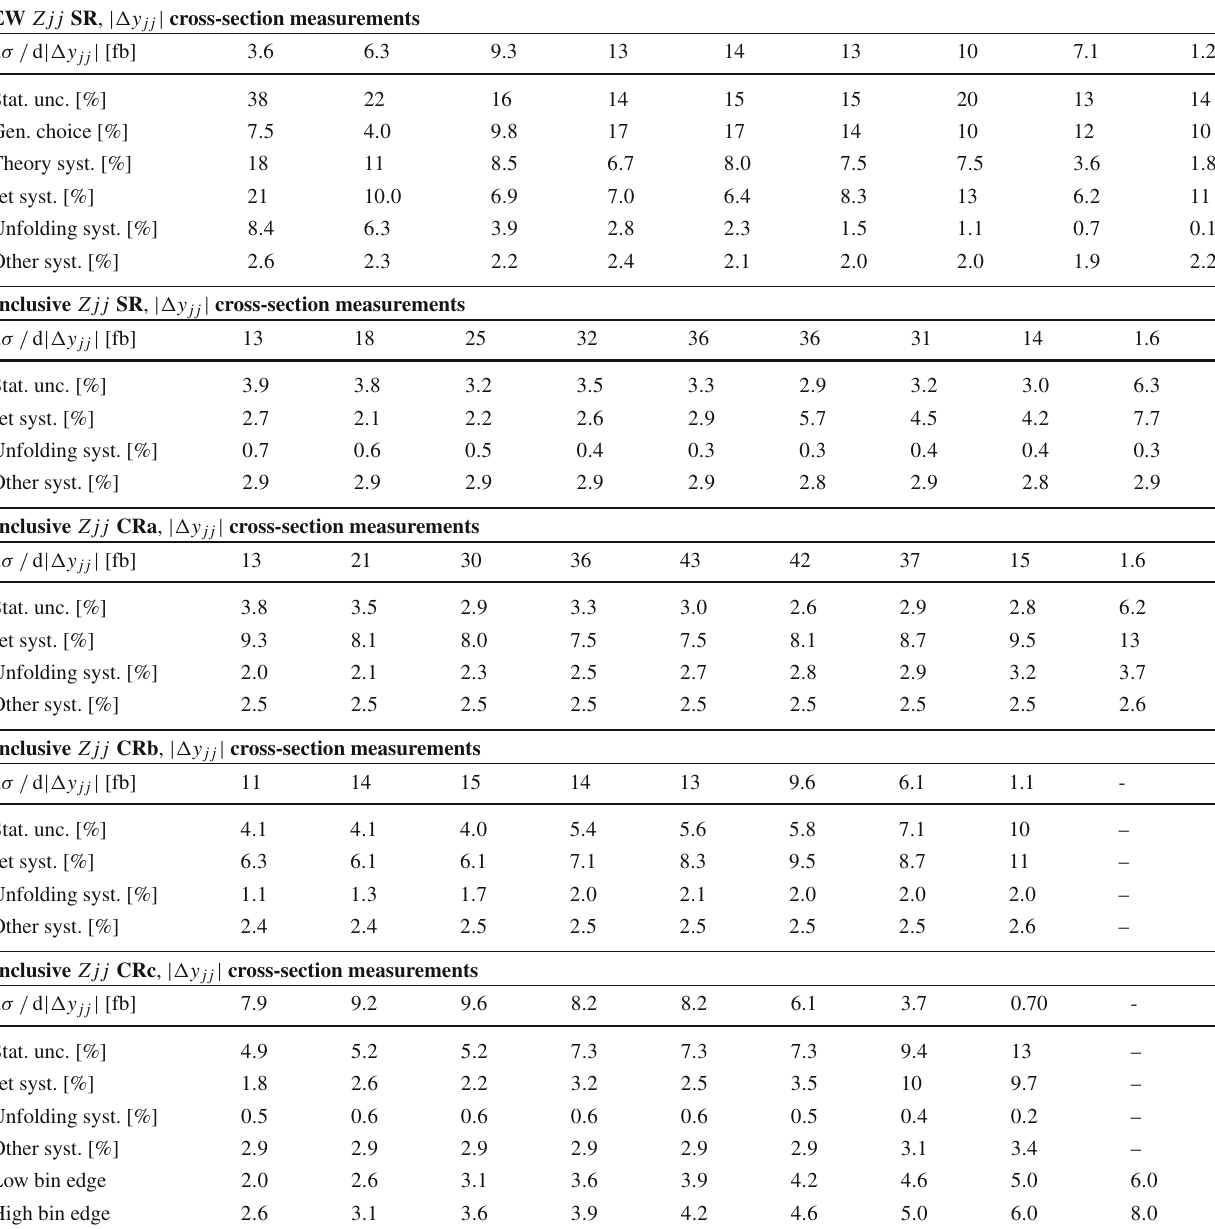
Table 6 Differential cross-section measurements for EW Zjj production and inclusive Zjj production as a function of | (cid:4) y jj | . The EW Zjj measurements are performed in the signal region. The inclusive Zjj measurements are performed in the signal region and three control regions. The different sources of uncertainty are grouped together for each measurement, with a more granular breakdown of each uncertainty available in